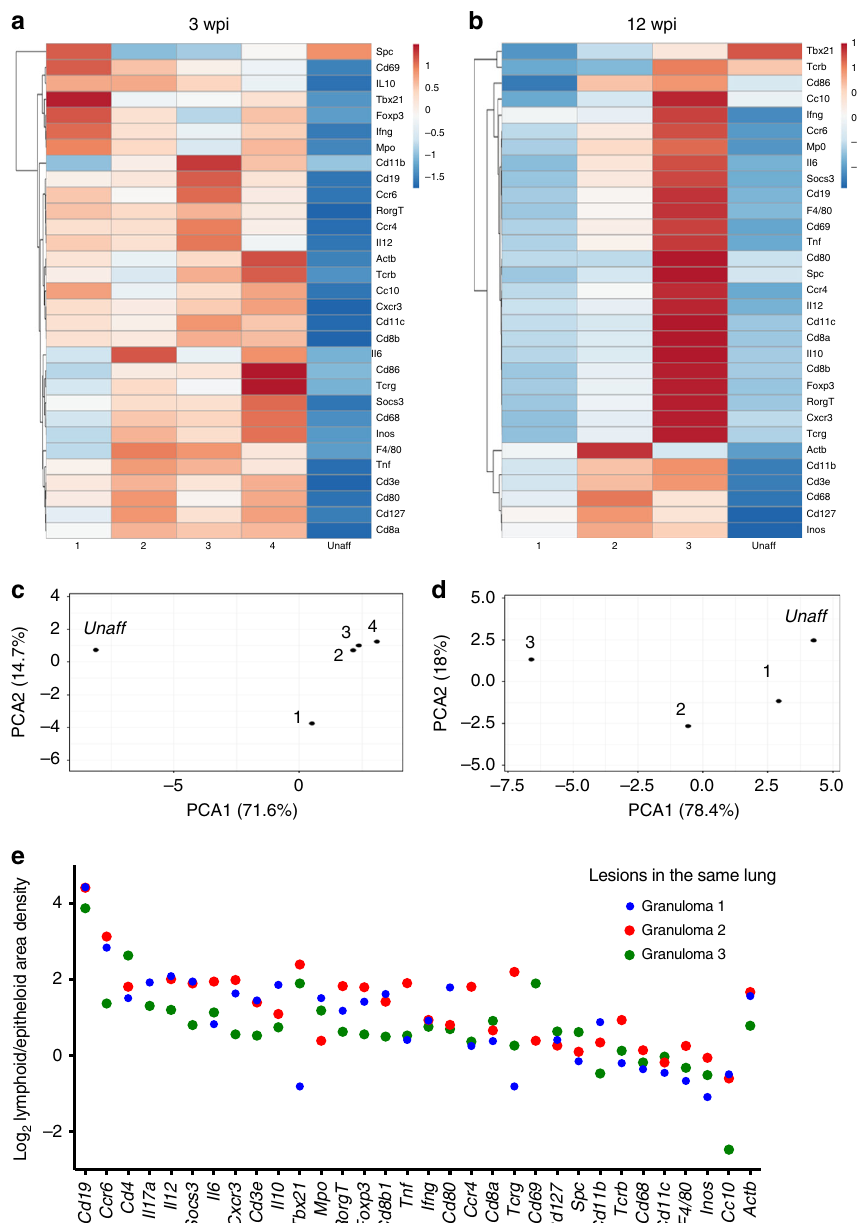
Fig. 5 Heterogeneity of granulomas in the same lung. a – d Heat map analysis depicting the transcript density in different granulomas as de fi ned in Supplementary Fig. 1 at 3 ( a ) and 12 ( b ) wpi normalized per area. To simplify the description of the data, results were processed by a multivariate principal component analysis ( c , d ), showing that although some granulomas cluster together with respect to their transcripts titers, others segregate from these as well as from the unaffected area. One representative result of three consecutive sections per time point is shown. e The density of sequences in lymphoid and epithelioid areas of individual granulomas of one tissue section 12 wpi was extracted. The ratio of sequence density of epithelioid and lymphoid areas per granuloma in the three different granulomas in the same lung was quanti fi ed and depicted. Source data are provided as a Source Data fi and tumors 28 . Different to ectopic lymphoid tissues in other pathologies 29 , a clear distinction of T-cell areas and B follicles is not evident in lungs from M. tuberculosis -infected C57BL/6 mice.